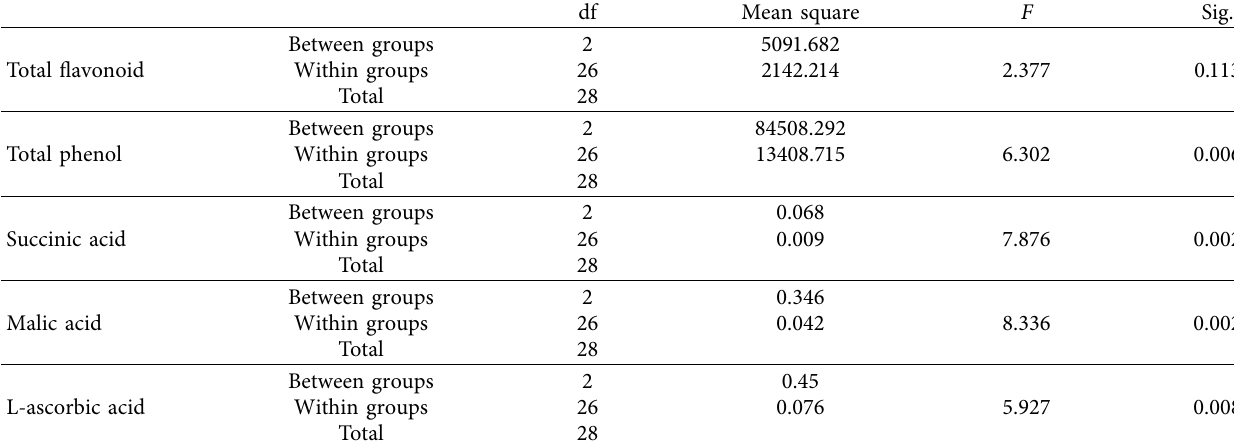
Table 3: ANOVA results.